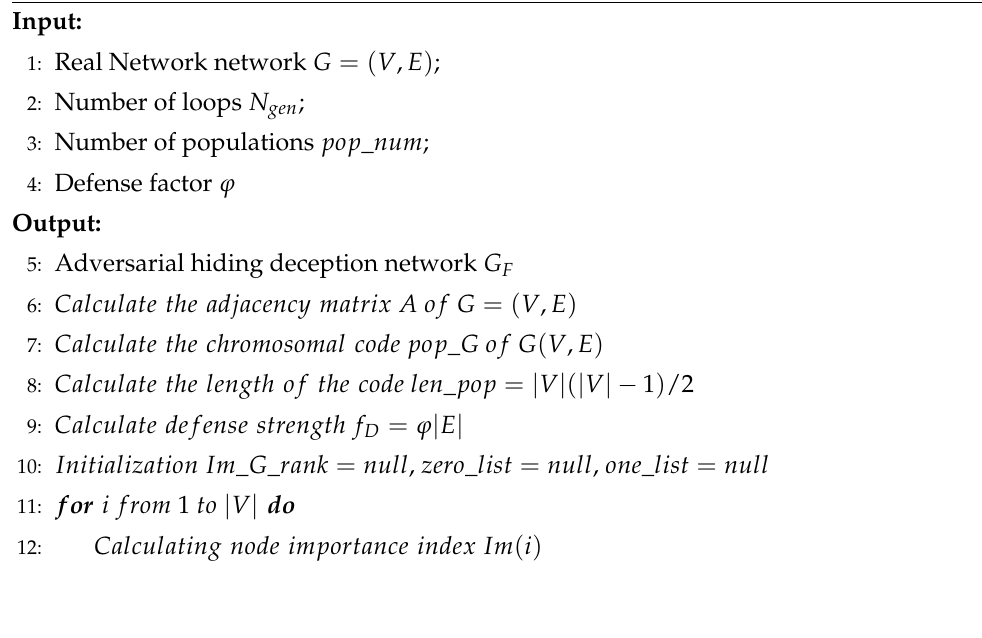
Algorithm 1 Adversarial hiding deception network optimization method based on genetic